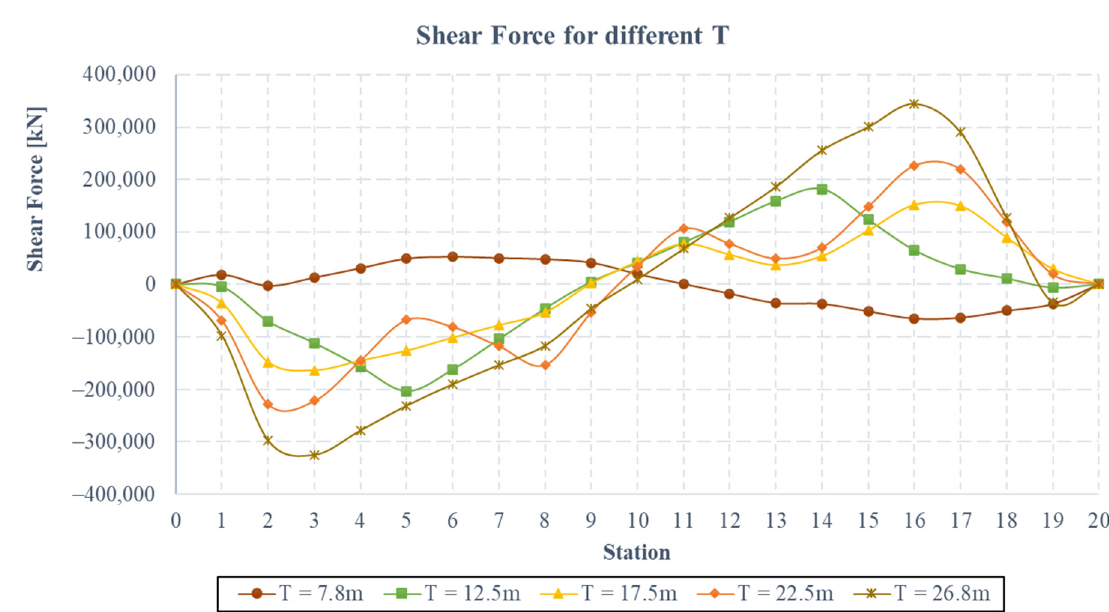
Figure 4. Shear force distribution for several draughts.